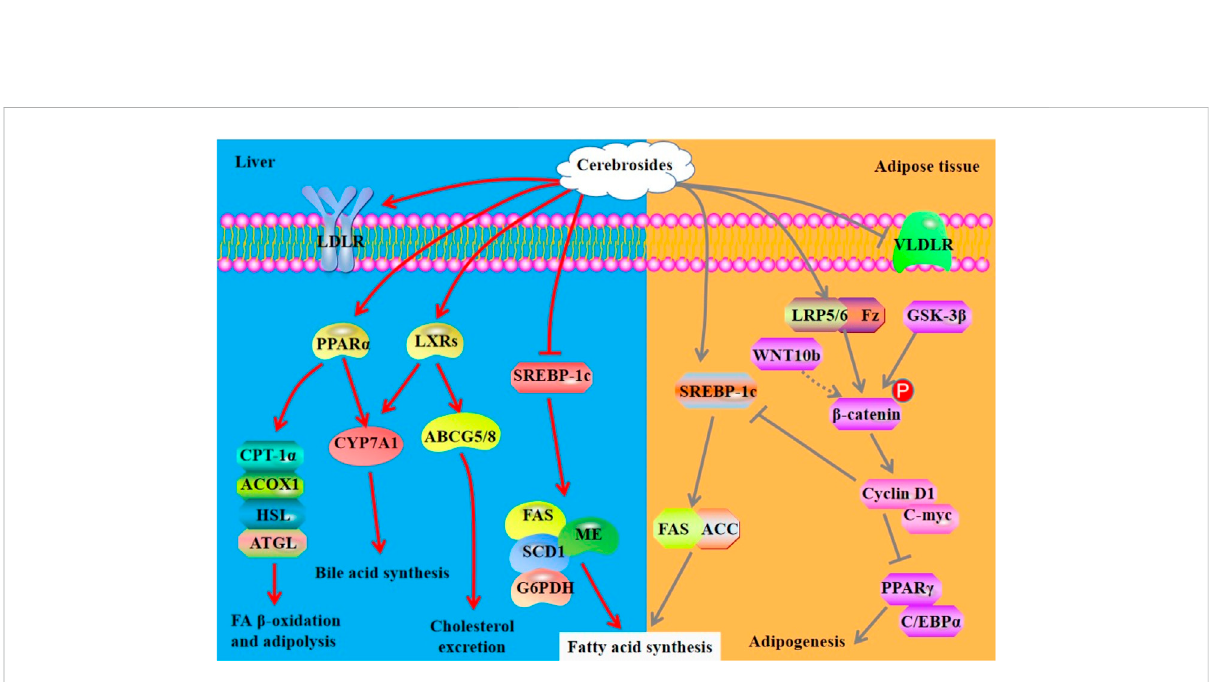
FIGURE 4 Mechanisms of action of cerebrosides derived from sea cucumbers. ACC, acetyl-CoA carboxylase; ATGL: adipose triglyceride lipase; GSK-3 β , glycogen synthase kinase-3 β ; HSL, hormone sensitive lipase; LRP, lipoprotein receptor related protein; VLDLR, very low-density lipoprotein receptor; WNT10b, wingless-type MMTV integration site10b. All the abbreviations are applicable for the rest